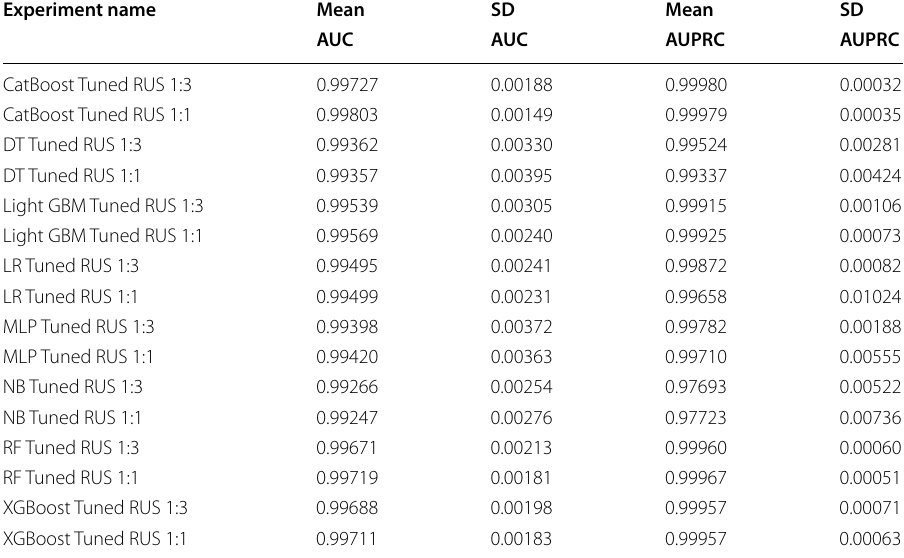
Table 4 Classification results for the information theft dataset with sampling and tuned hyperparameters experiments; mean and standard deviations of AUC and AUPRC, (10 iterations of 5-fold